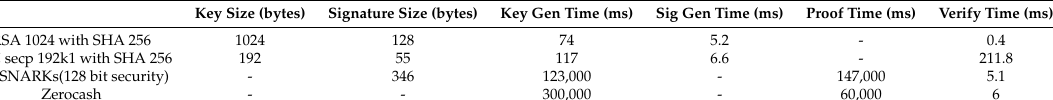
Table 8. A comparison of the efficiencies of cryptography methods.